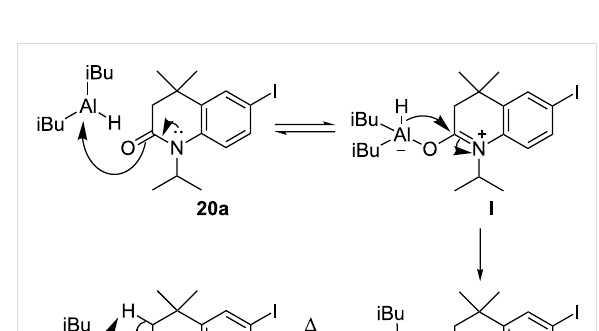
quenched with 20% aq w/v NaOH, extracted in EtOAc, washed with H